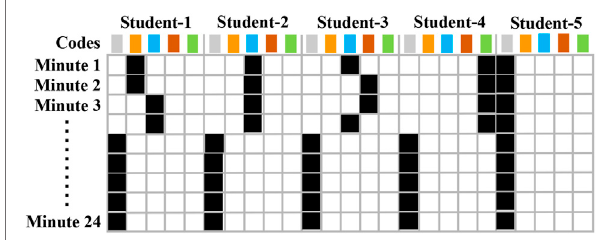
FIGURE 7 | Illustration of a spatio-temporal data sample. Black colored cells indicate the code that was assigned to each student during the task. Colored boxes indicate the different codes at levels B2 and